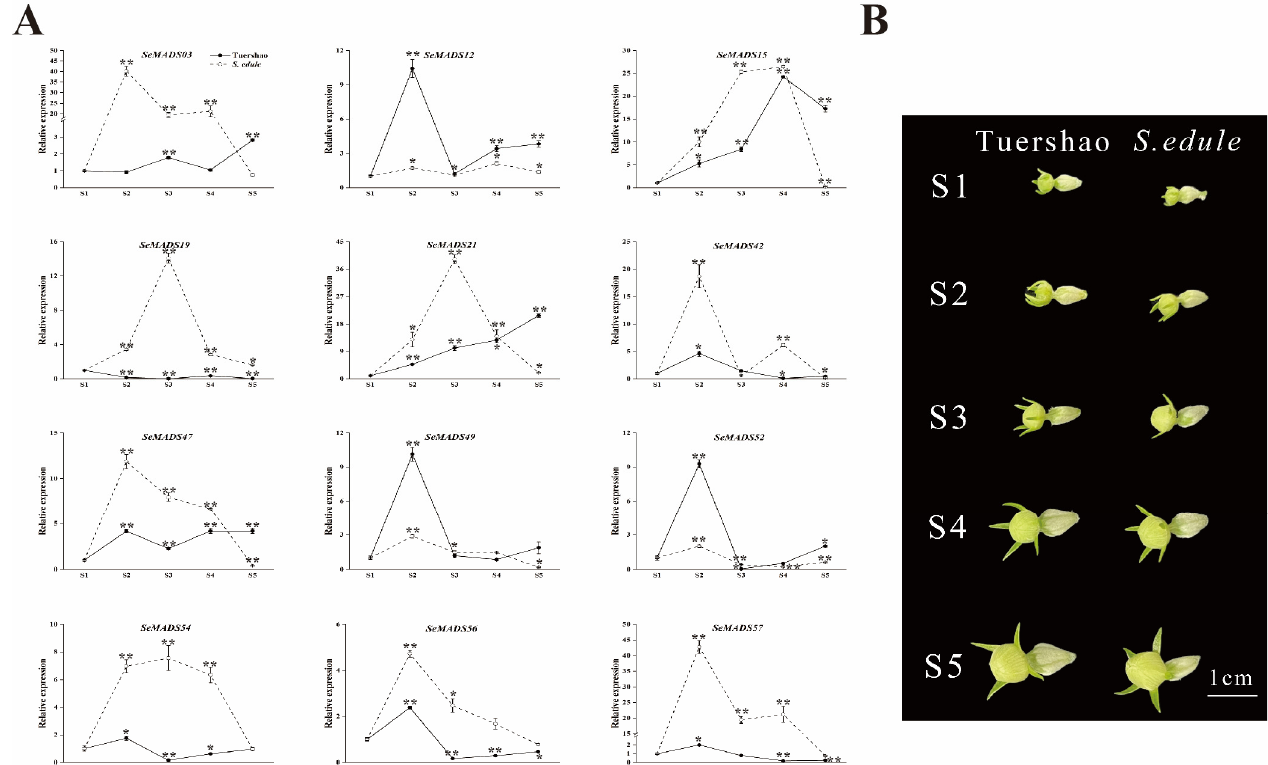
Figure 11. Comparison of expression patterns of the SeMADS-box at different female flower devel- opment stages in ‘Tuershao’ and S.edule . ( A ) SeMADS-box gene expression pa tt ern. ( B ) Female fl ow- ers at di ff erent development stages. Asterisks represent the signi fi cant di ff erence at the same devel- opmental stage point (* p < 0.05; ** p < 0.01).